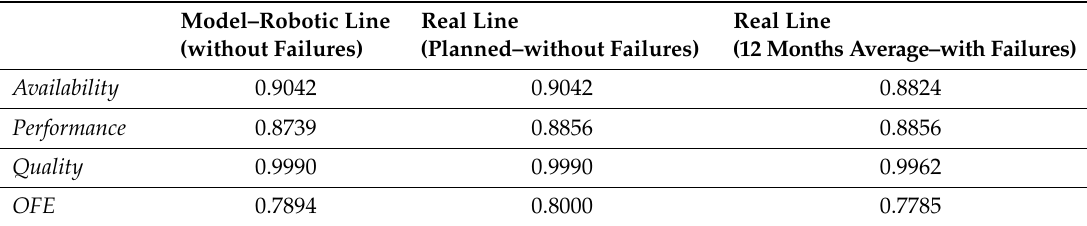
Table 5. OFE components comparison—model assumption and real robotic